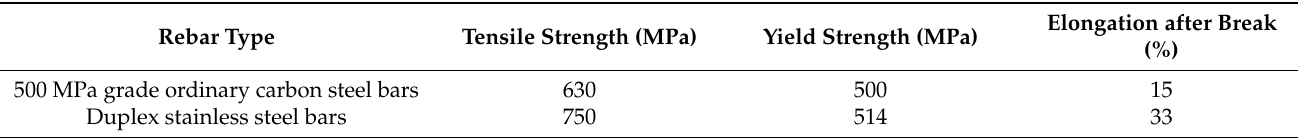
Table 4. A comparison of the basic mechanical properties of 500 MPa grade plain carbon steel bars and duplex stainless steel bars.